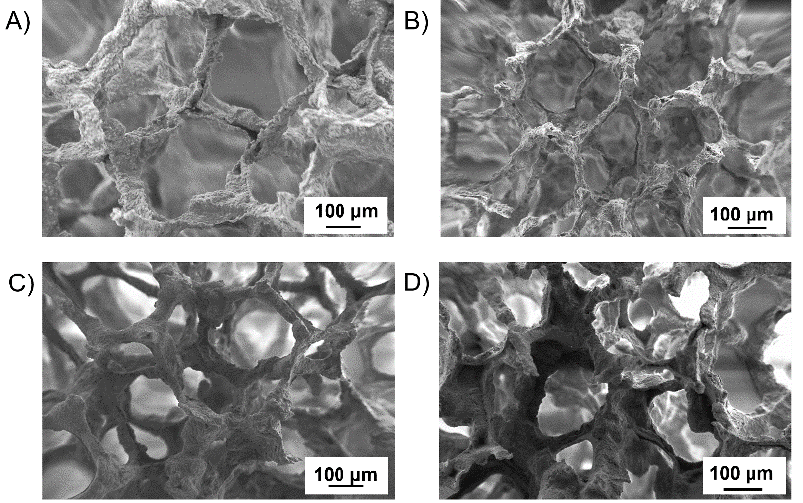
Figure 5. SEM images of a BG scaffold coated in a KHC2000E2000 solution in chloroform with 0.5% w / v ( A , B ) or 1% w / v ( C , D ) concentration through a 1-min ( A , C ) or a 1-day ( B , D ) dip-coating procedure. Considering that the 1-min dip-coating procedure in a polymer solution at 1% w / v concentration resulted to be the best condition to coat BG scaffolds with KHC2000E2000, the same procedure was adopted to produce KHC2000/BG scaffolds. However, KHC2000- coated BG scaffolds according to this protocol reported many clogged pores, probably because of the higher viscosity of 1% w / v KHC2000 solution compared to KHC2000E2000- based one with the same concentration as a consequence of its higher molecular weight (Figure 6A). Hence, KHC2000 solution concentration was decreased to 0.5% w / v . Com- posites produced with a 1-min dip-coating procedure of BG scaffolds in a 0.5% w / v concentrated KHC2000 solution exhibited a highly porous structure with no clogged pores (Figure